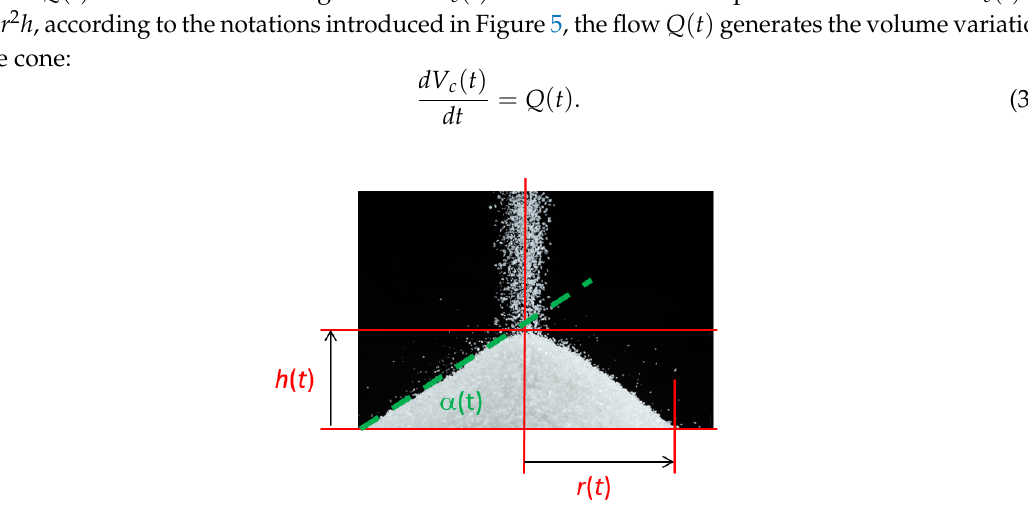
Figure 5. Notations for the characterisation of the sand heap growth.